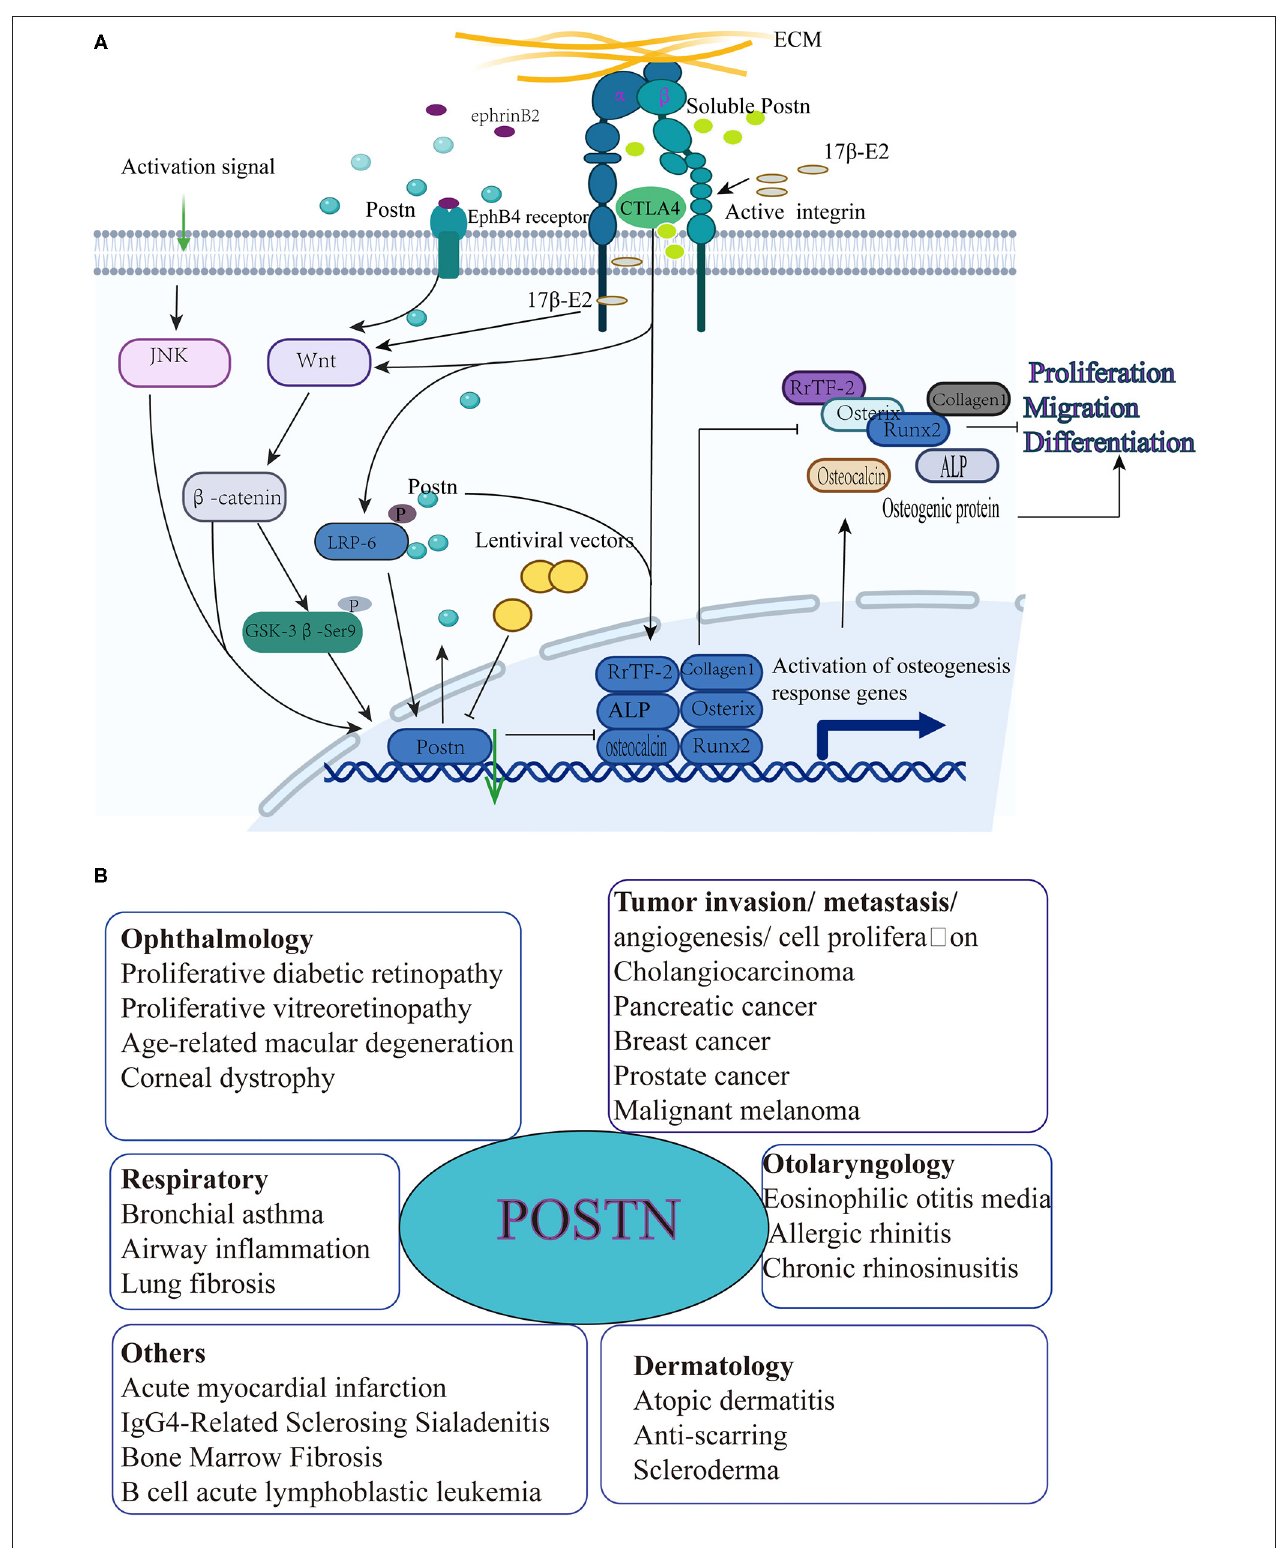
FIGURE 2 | (A) POSTN induces osteogenic differentiation, migration, and proliferation of MSCs. (1) The receptor erythropoietin-producing hepatocyte B4 (EPHB4) interacts with ephrin B2, thereby inducing POSTN expression, which in turn promotes the expression of p-GSK-3- β (Ser9); this leads to the downregulation